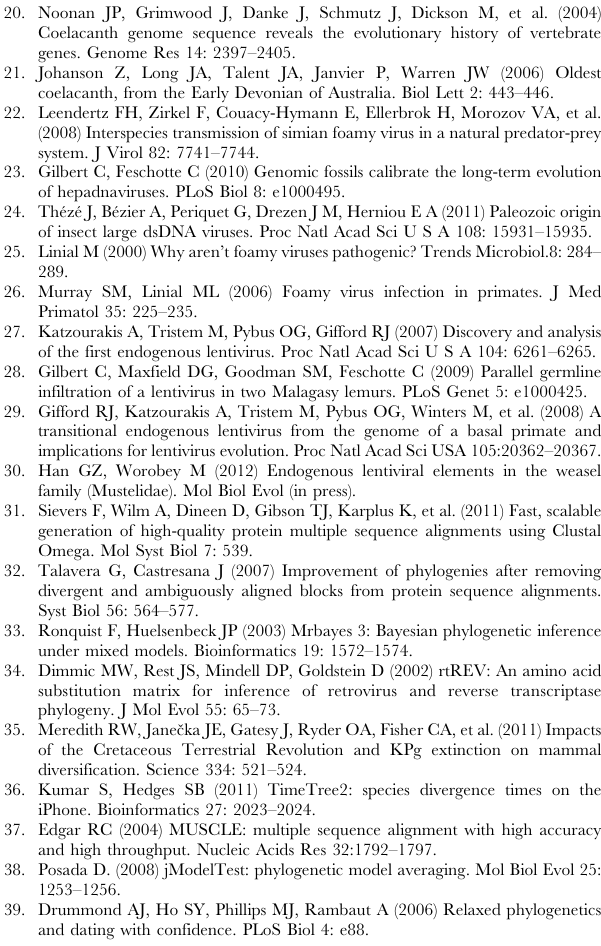
Figure S6 A) Midpoint rooted phylogenetic tree of foamy viruses. The phylogeny is the 50% majority-rule consensus tree inferred from conserved region of foamy virus Env protein alignment with MrBayes 3.1.2. Posterior probabilities are shown at the nodes. Branch lengths are in expected amino acid changes per site. B) A plot of the correlation between foamy virus divergence and their vertebrate hosts’ divergence times. The virus branch lengths are derived from the virus tree in A. Table S1 The representative retrovirus sequences used for genome screening and phylogenetic reconstruction.